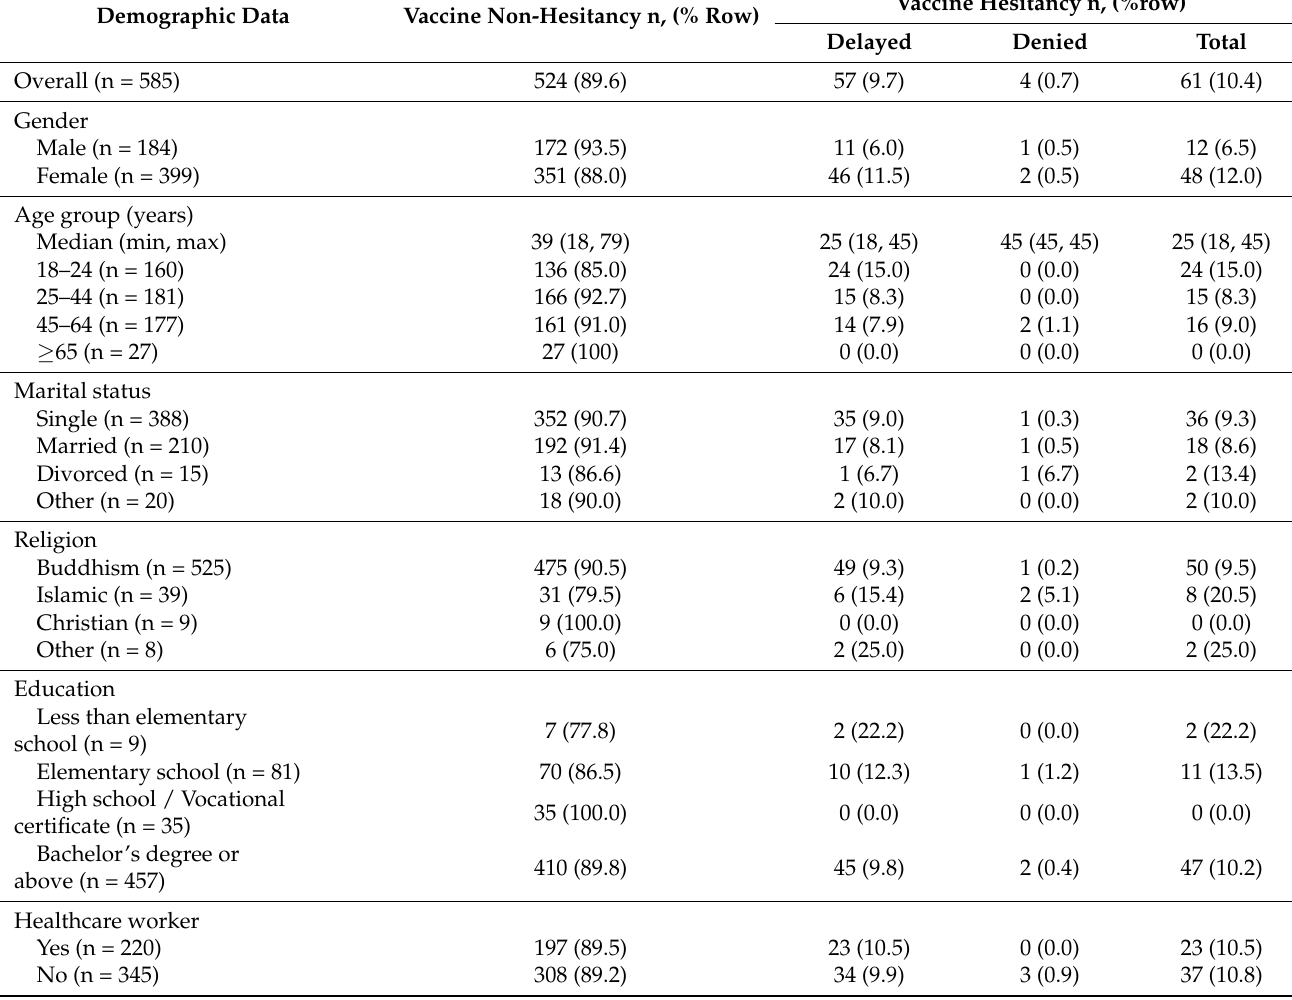
Table 2. Relationship between demographic data and COVID-19 vaccine hesitancy (n =